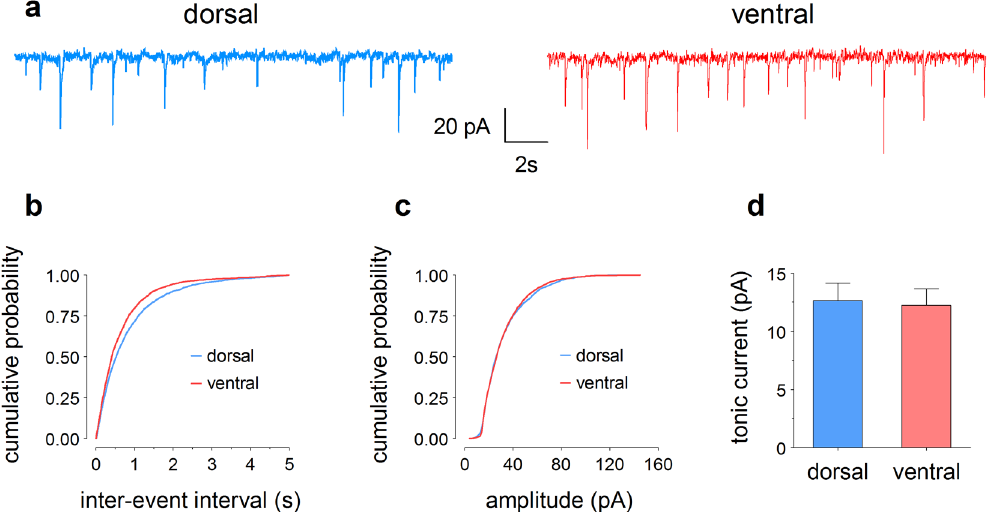
Figure 4. Whole-cell patch-clamp recordings reveal differences in inhibitory properties between dorsal and ventral DG granule cells. ( a ) Representative traces of miniature inhibitory postsynaptic currents (mIPSCs) of granule cells in slices from dorsal (blue) and ventral (red) hippocampus. ( b ) Cumulative probability curves indicate significantly shorter median inter-event intervals, i.e. a higher frequency of mIPSCs, in the ventral (409 ms) compared to dorsal DG (524 ms). ( c ) In contrast, the median mIPSC amplitudes are not different (dorsal: 26.6 pA, ventral: 26.9 pA). ( d ) Tonic currents in dorsal and ventral granule cells, calculated as the difference between the holding current in the absence and presence of 50 mM bicuculline, are almost identical (dorsal: 12.6 ± 1.5 pA, ventral: 12.2 ± 1.4